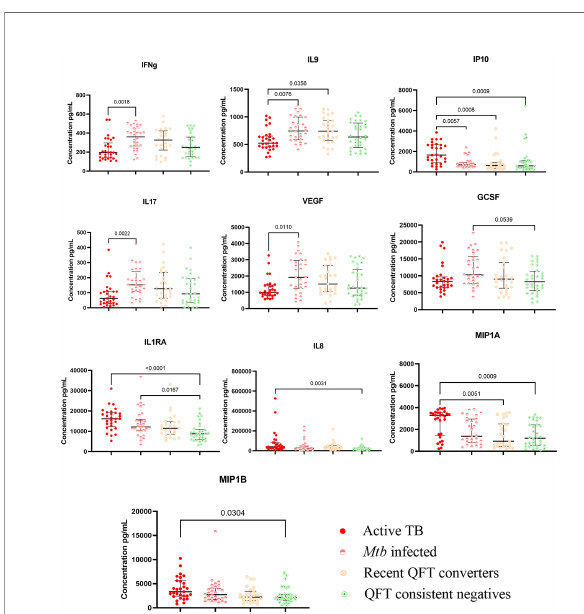
FIGURE 2 | Kruskal – Wallis test with Dunn ’ s post correction was applied. Scatter-plot graph depicting median cytokine concentrations (pg ml − 1 ) from the QFT-GIT supernatants (nil tube) by the Multiplex bio-plex assay. Nil levels (pg ml − 1 ) of IFN g , IL9, IP10, IL-17, VEGF, GCSF, IL1RA, IL8, MIP1 a , and MIP1 b in patients with active TB (ATB; n = 29), Mtb infected (n = 30), recent QFT converters (n = 27), and QFT consistent negatives (n = 32).